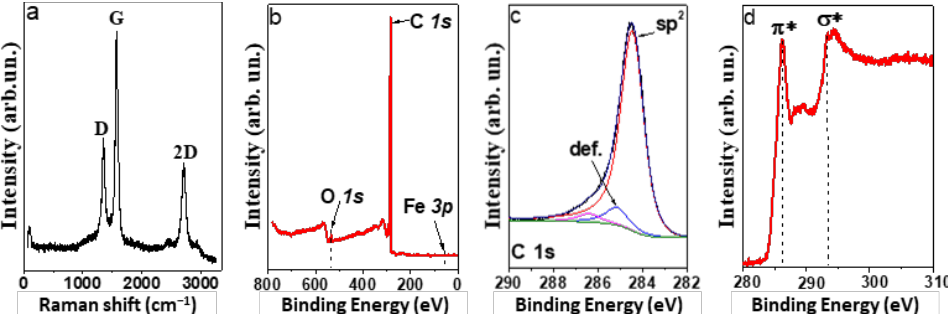
Figure 4. Raman spectrum ( a ), survey XPS spectrum ( b ), XPS C 1 s spectrum ( c ), and NEXAFS C K-edge spectrum ( d ) of MWCNT array.